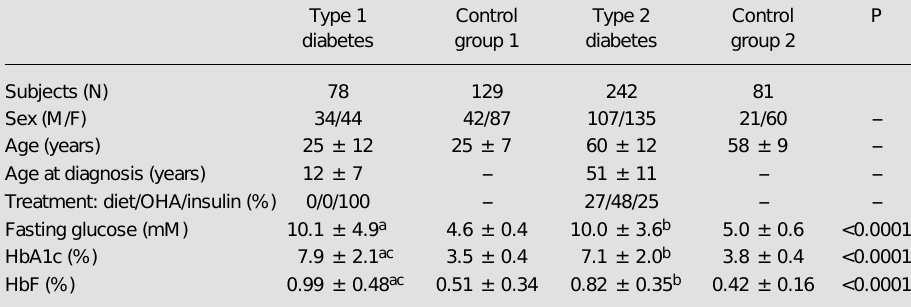
Table 1 - Demographic and biological profile of patients and controls. Data are reported as means ± SD. OHA, Oral hypoglycemic agents. a P<0.05 compared to control group 1; b P<0.05 compared to control group 2 (ANOVA); c P<0.05 compared to type 2 diabetes subjects (ANOVA followed by the Tukey-Kramer HSD